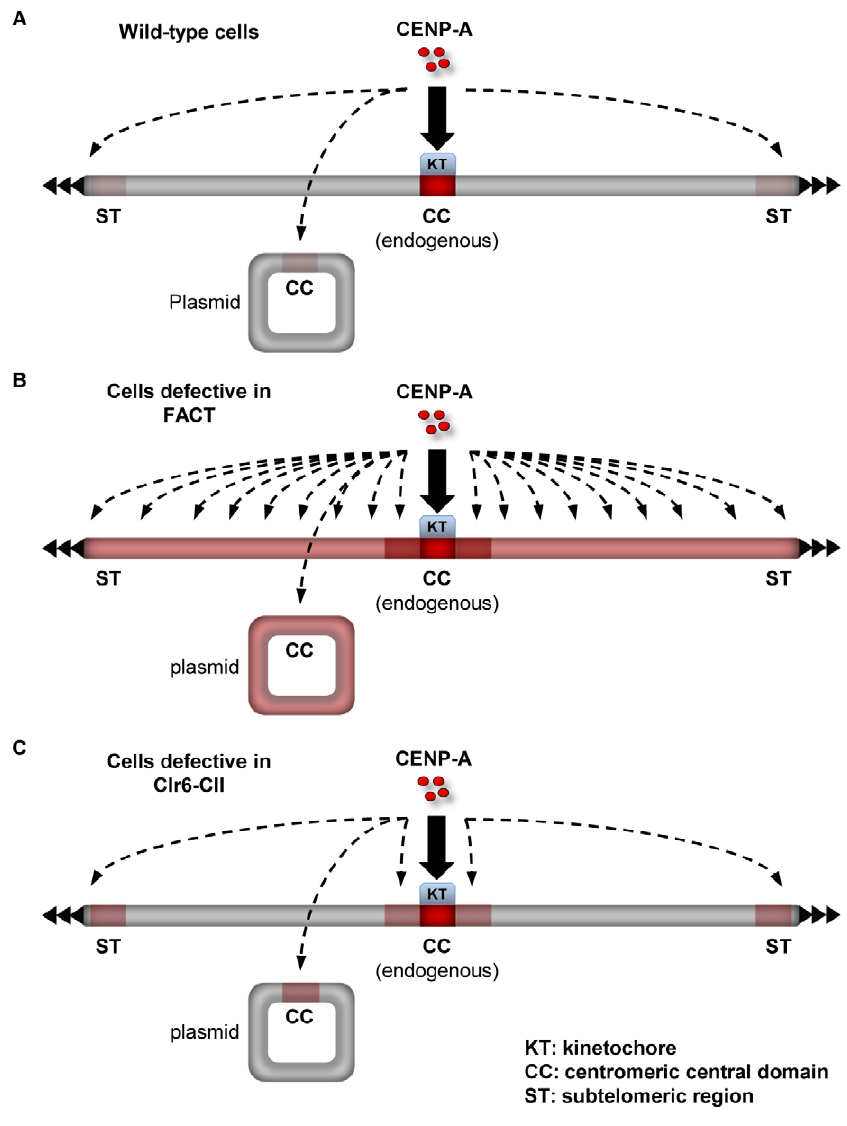
Figure 7. Summary on the role of factors that promote the integrity of H3 chromatin during transcription in preventing promiscuous CENP-A Cnp1 deposition. (A) In wild-type cells, a limited amount of free CENP-A Cnp1 is available to accumulate outside endogenous centromeres at which kinetochore proteins act to attract CENP-A Cnp1 . This limited pool of free CENP-A Cnp1 can be preferentially deposited to specific sites such as centromeric central domain (CC) and subtelomeric regions (ST). Intensity of red color on the chromosome and the plasmid represents relative ‘‘receptiveness’’ of the locus for CENP-A Cnp1 incorporation. Bold arrow indicates regions where CENP-A Cnp1 incorporation normally occurs without overexpression (i.e. centromeres). Dashed arrows indicate regions where de novo assembly of CENP-A Cnp1 is expected under conditions where CENP-A Cnp1 deposition is stimulated (e.g. when CENP-A Cnp1 is overexpressed or flanking heterochromatin is provided). (B) In cells with defective FACT, non-centromeric regions become permissive to CENP-A Cnp1 (indicated by red color all over the chromosome and the plasmid). Endogenous centromeres drive CENP-A Cnp1 assembly at proximal euchromatic regions when they become permissive to CENP-A Cnp1 assembly (indicated by dark red color at centromere-proximal regions). CENP-A Cnp1 incorporation when overexpressed is not significantly elevated at CC and ST in FACT mutants compared to wild-type cells, suggesting that FACT action may be already limited at these sites. Without CENP-A Cnp1 overexpression, the limited pool of free CENP-A Cnp1 is distributed to non-centromeric regions and cannot accumulate at normally preferred sites such as CC and ST. (C) In cells with defective Clr6-CII, only specific regions such as centromere-proximal euchromatic regions, CC and ST become permissive to CENP- A Cnp1 . Clr6-CII has a weaker impact on H3 chromatin compared to FACT and thus loss of Clr6-CII function promotes CENP-A Cnp1 incorporation only at regions where CENP-A Cnp1 assembly is predisposed (centromere-proximal regions) or FACT action is limited (CC and ST). In Clr6-CII mutants, limited pool of free CENP-A Cnp1 is not distributed and can accumulate at preferred sites, allowing de novo assembly of CENP-A Cnp1 chromatin on a plasmid bearing CC in the absence of flanking heterochromatin.